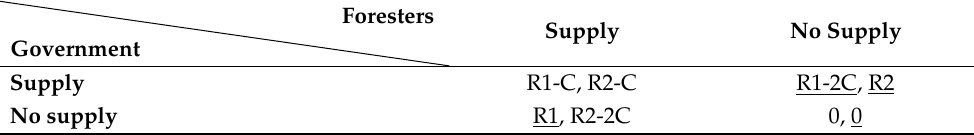
Table 1. The static game of incomplete information between forestry farmer and government.